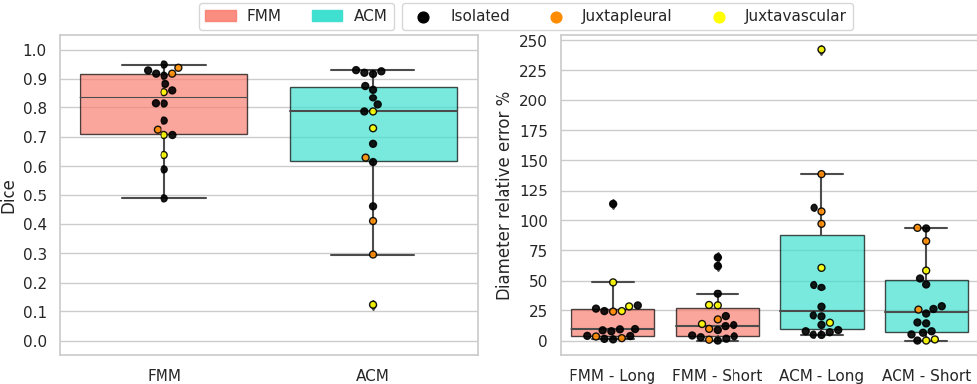
Figure 15. Sub-solid nodules’ objective evaluation results as boxplots, overlayed with the values of individual cases divided into